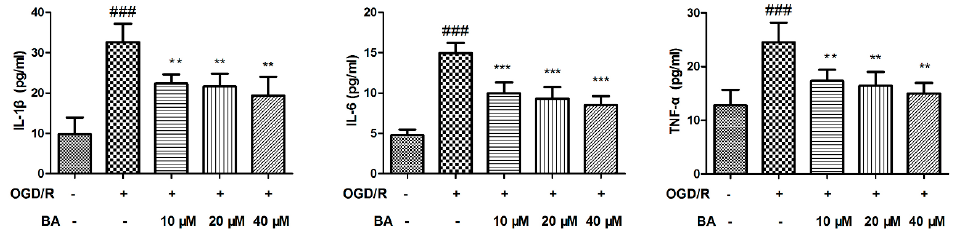
Figure 5. The influence of BA on the level of inflammatory cytokines in OGD/R-induced SHSY5Y cells compared with control cells (### p < 0.001) and compared with OGD/R cells (** p < 0.01, and *** p < 0.001).